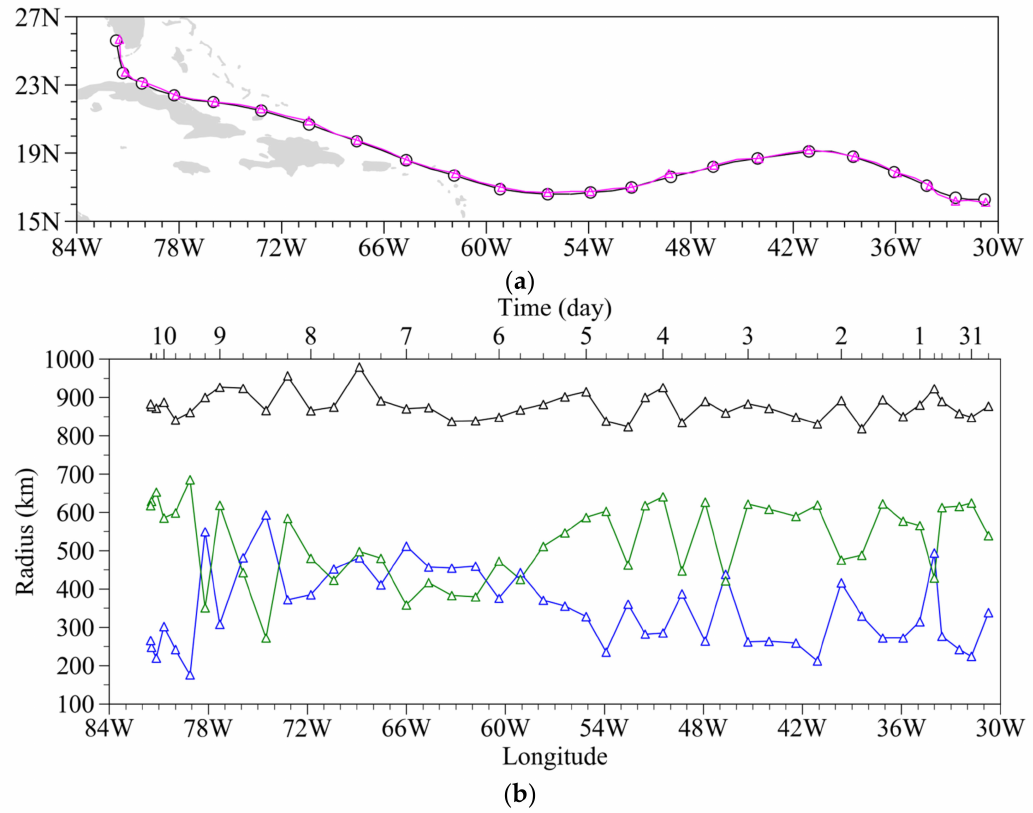
Figure 6. ( a ) Tracks of ABI-determined TC center (magenta open triangle) and the best track center (black open circle) of Irma at 12 h intervals from 1800 UTC on August 30 to 1800 UTC September 10, 2017. ( b ) Variations of the R OR (black curve with open triangles), R IR (blue curve with open triangles), and the difference (green curve with open triangles) at 6 h intervals during Irma’s lifetime. The longitudes of and times of Irma’s centers are also indicated in ( b